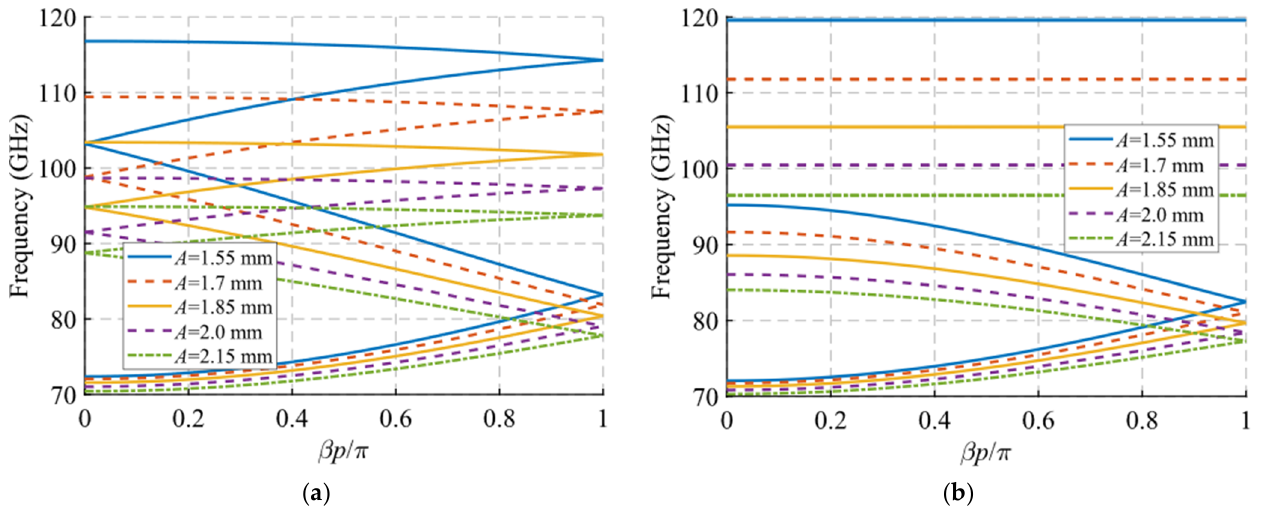
Figure 8. Dispersion diagram of the double-periodic unit cell for various values of A . ( a ) Glide- symmetric configuration ( d = 0.725 mm) and ( b ) maximum rupture of symmetry configuration ( d = 0